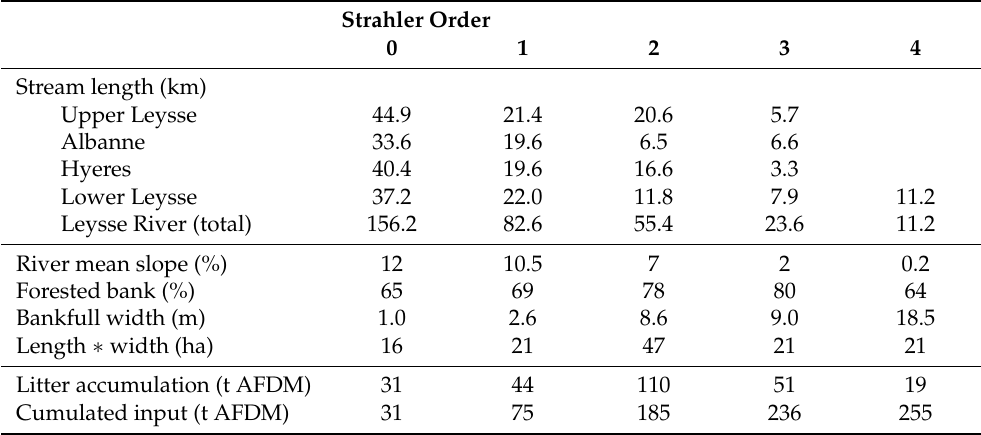
Table 1. Stream characteristics, litter accumulation on river banks in autumn (t AFDM) in relation to stream order and cumulated input. Intermittent streams are named as Strahler order 0. Cumulated litterfall inputs are computed from